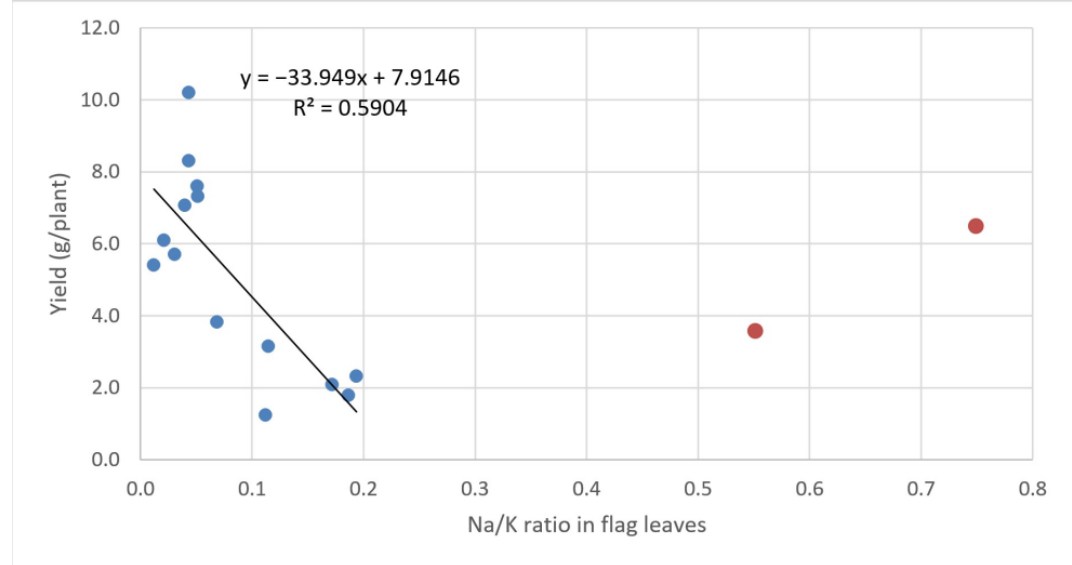
Figure 4. The relation between Na/K ratios in flag leaves and the yield of eight rice varieties under control and saline conditions. All dots show the average of three measurements. The red dots indicate the ‘M488’ variety.